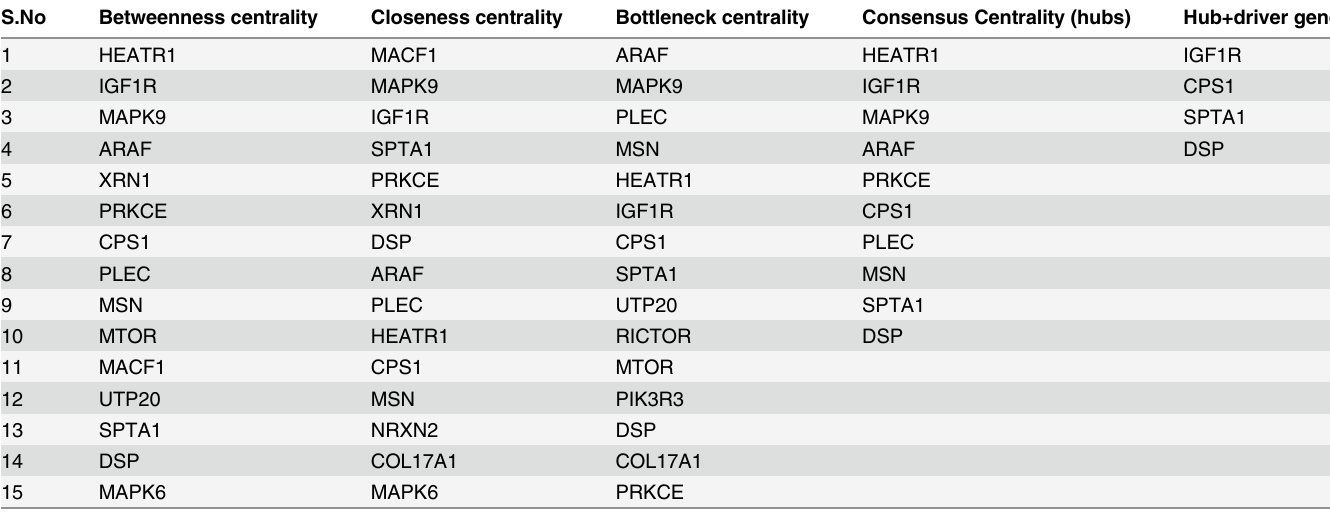
neurogenesis and oligodendrocyte development was seen (q-values < 0.001), which might seem surprising, but recent studies indicated a crucial link of these signaling pathways with the metastasis of colon cancer [26]. We performed the literature survey for these novel driver genes, to provide an insight into the possible roles of these genes in cancer progression. To our surprise, most of the genes were under studied in connection with colon cancer. Table 5. Centrality analysis of stage-III network.